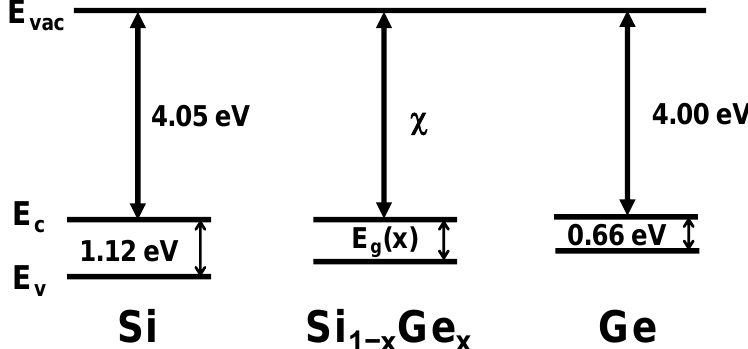
Figure 5. Energy band diagram of Si, SiGe, and Ge.